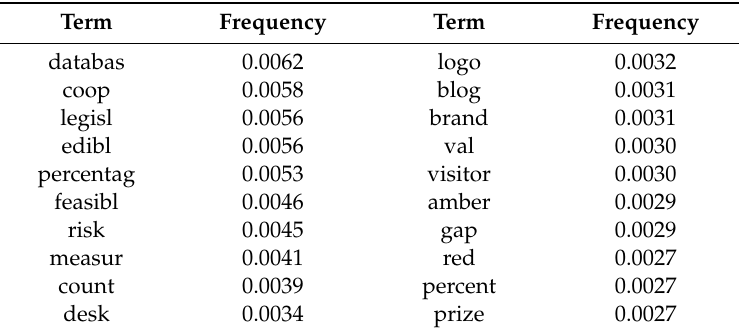
Table 4. First 20 terms using descending Tf-Idf